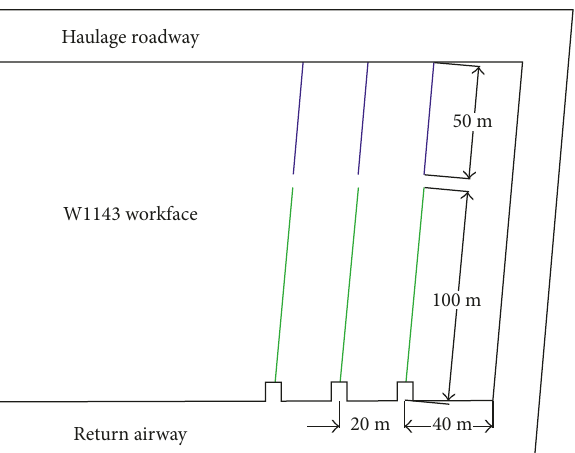
Figure 17: Plane section layout diagram of water injection in coal mining